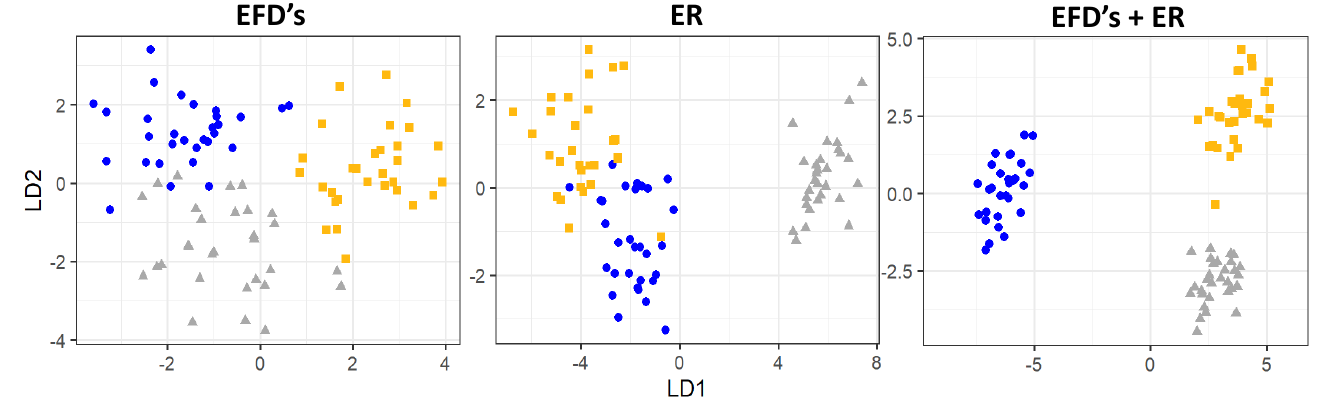
Figure 6. Scatterplot of the first and second discriminant function scores for the elliptical Fourier descriptors (EFDs), Element:Ca ratios (ER) and both (EFDs + ER) for Micropogonias furnieri individuals sampled in the study area (yellow squares: North; grey squares: Center; blue squares: South).